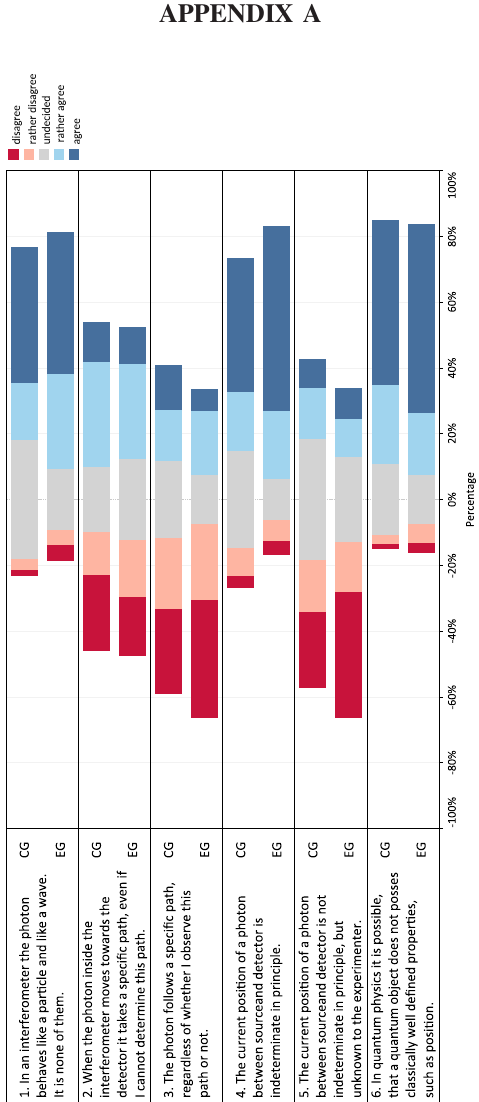
FIG. 13. Diverging stacked bar chart visualizing the distribu- tion of student ratings on all items of the scale on the probability interpretation of quantum physics (cf. Table